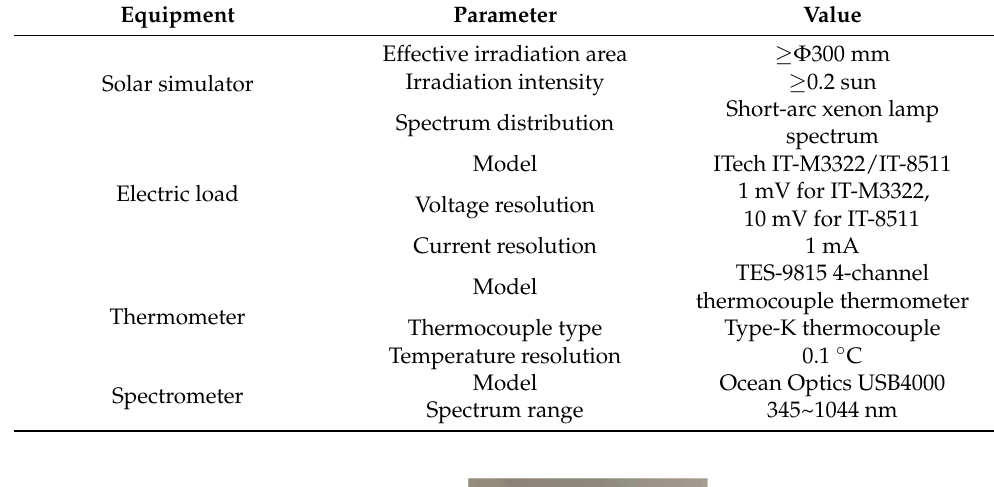
Table 6. Equipment parameters used in the test.